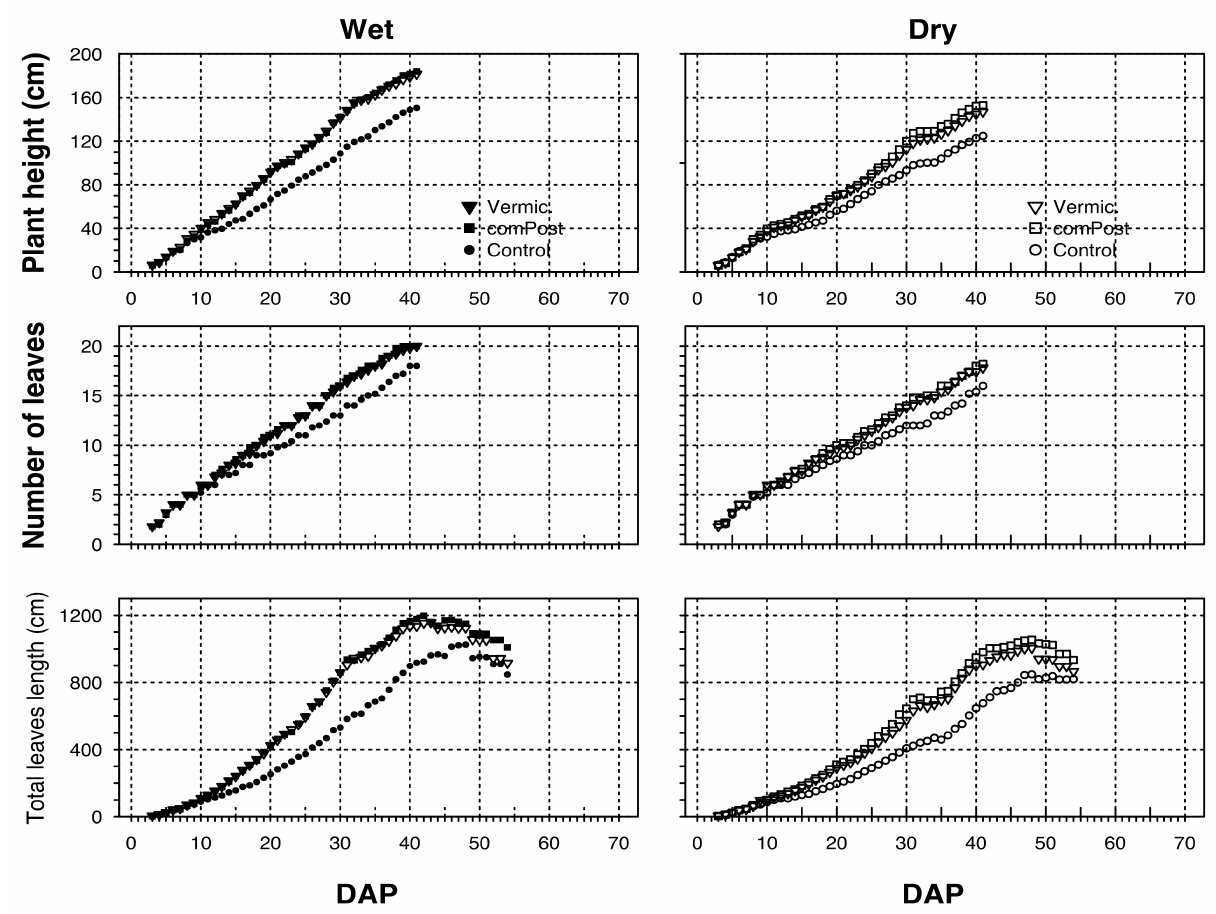
Figure 3. Daily record of the plant height (in cm, top ), number of leaves ( middle ), total leaves length (in cm, right ) for the wet ( left ) and dry ( right ) treatments. Values are means ( n = 5), error bars represent the standard deviation, but they were not presented as they were smaller than the